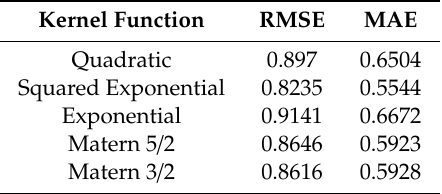
Table 4. Performance of various kernel functions for the GPR model.